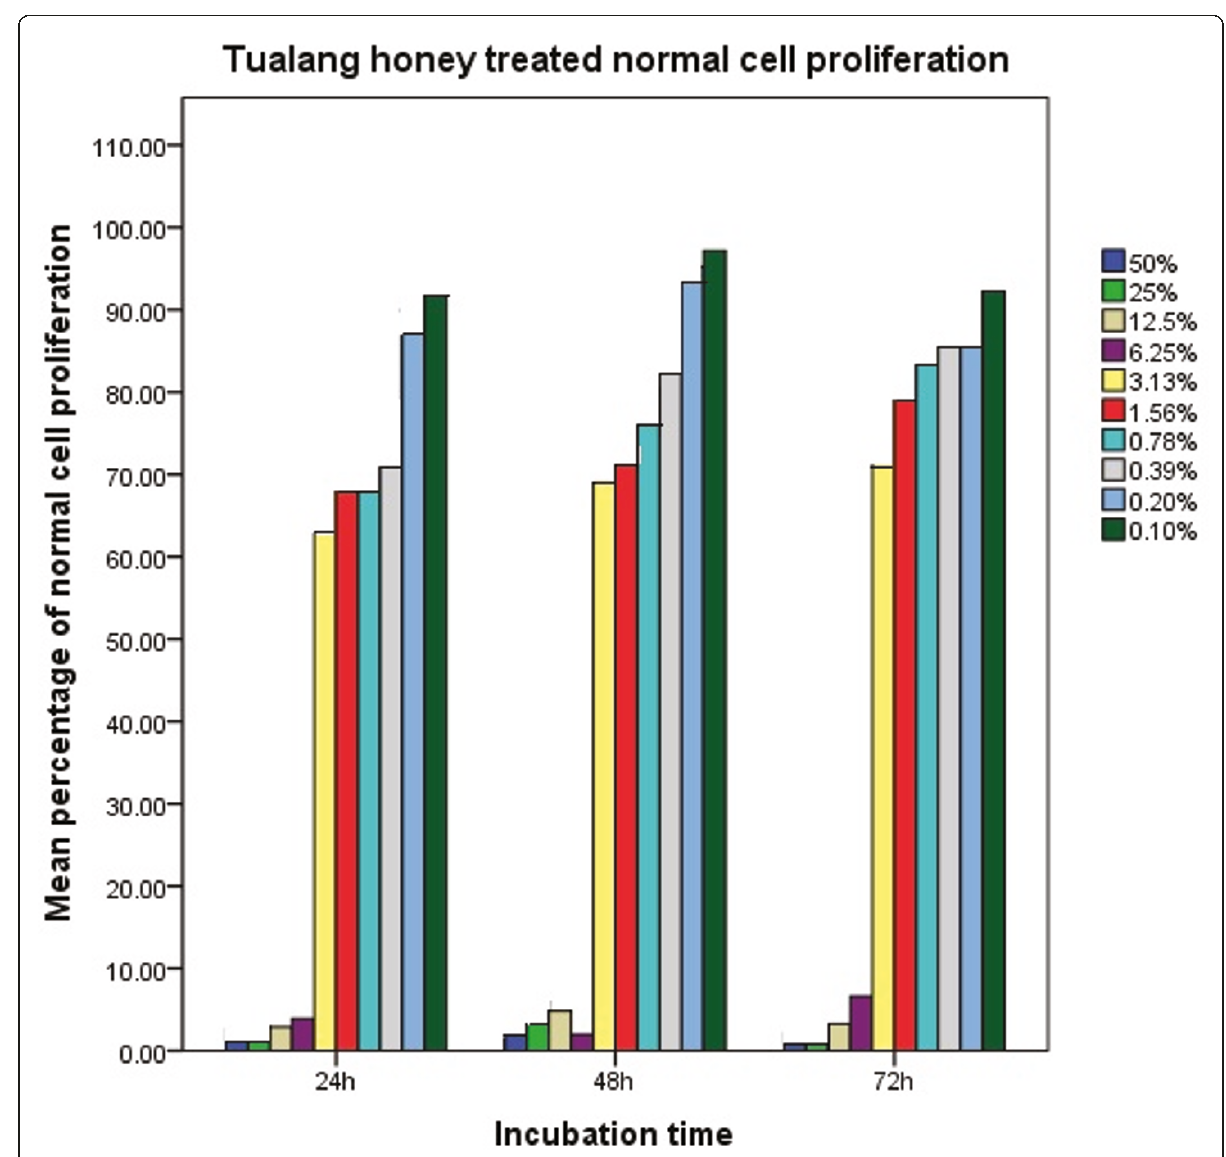
Figure 1 Proliferation of normal cells following 24, 48 and 72 hrs of incubation with various concentrations of methanolic extract of Tualang honey